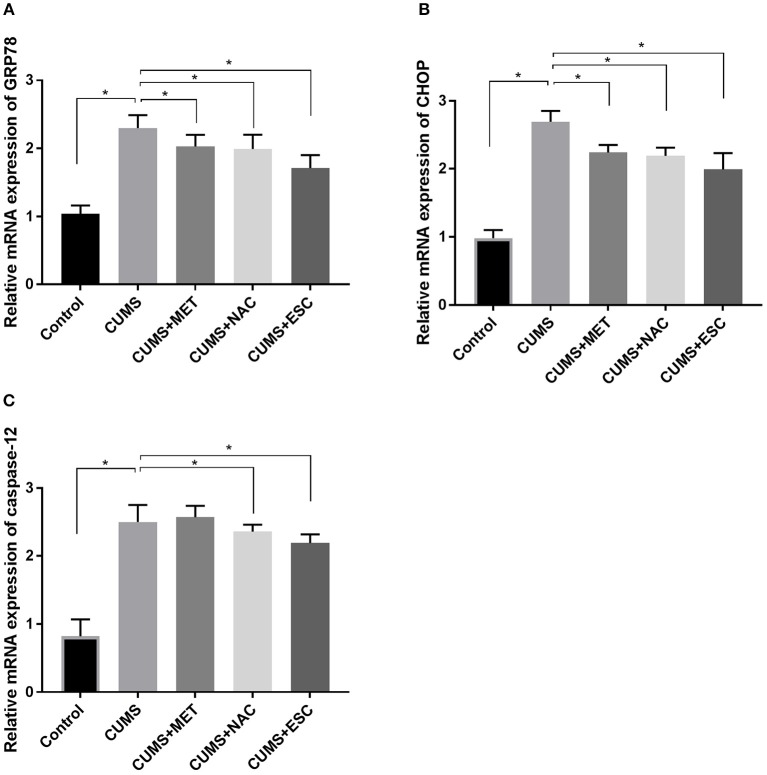
Effect of MET, NAC, and ESC on the mRNA levels of ERS markers in CUMS-induced rats. (A) The relative mRNA expression of GRP78 in hippocampus of each group after stress. (B) The relative mRNA expression of CHOP in hippocampus of each group after stress. (C) The relative mRNA expression of caspase-12 in hippocampus of each group after stress. *P < 0.05 (one way ANOVA), n = 9.